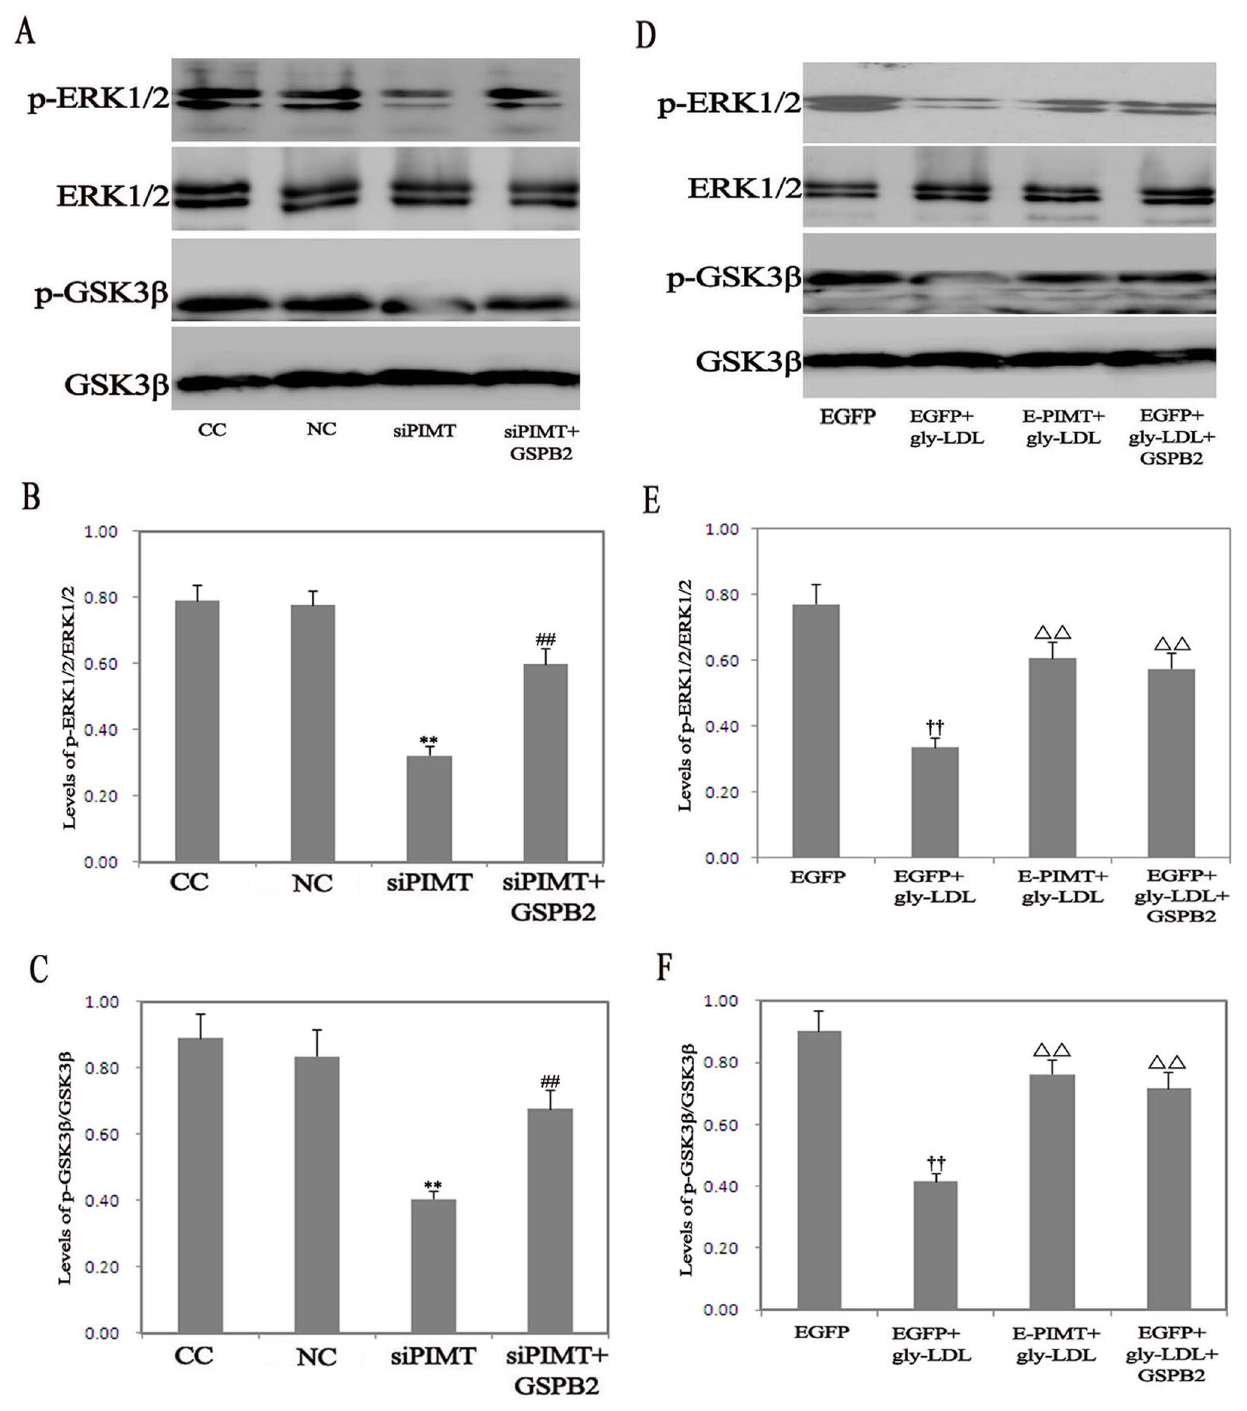
Figure 8. Effects of PIMT on phospho-ERK1/2 and phospho-GSK3 b in HUVEC treated by gly-LDL. A, B, C: Effects of PIMT siRNA, GSPB2 on phospho-ERK1/2 and phospho-GSK3 b in HUVEC. D, E, F: Effects of PIMT overexpression, GSPB2 on phospho-ERK1/2 and phospho-GSK3 b in HUVEC treated by gly-LDL. Data were expressed as the expression ratio of phospho-ERK1/2/ERK1/2, phospho-GSK3 b /GSK3 b and given as mean 6 SD from five independent experiments. * P , 0.05, ** P , 0.01 compared with NC group; # P , 0.05, ## P , 0.01 compared with siPIMT group. { P , 0.05, {{ P , 0.01 compared with EGFP group; D P , 0.05, DD P , 0.01 compared with EGFP + gly-LDL group. doi:10.1371/journal.pone.0069979.g008 These evidences demonstrate that GSK3 b may serve as an ERK1/2 activation is a pivotal pathway for integration and upstream signaling molecule in mitochondrial apoptotic pathway. transduction of antiapoptotic signals elicited by the paracrine component of endothelial apoptosis [46]. Several studies indicated